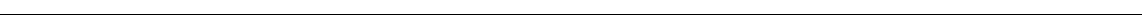
Fig. 1 Structure of the SepCysE-SepCysS-tRNA Cys ternary complex. a Orthogonal views of the ternary complex drawn in ribbon model. A dimer of the SepCysE N-terminal domain (SepCysE(NTD), yellow orange) is tightly bound to a dimer of SepCysS (blue) with their two-fold axes aligned. From one of the NTDs of the SepCysE dimer, a linker chain extends to the C-terminal domain of SepCysE (SepCysE(CTD), red), which in turn binds to the elbow region of tRNA Cys (orange). The CCA terminus of tRNA Cys is in contact with the active site of SepCysS. A stick representation of PLP is also drawn at the active site. Black and red dashed lines represent fl exible loops connected to the disordered N-helix and CTD of SepCysE, respectively. A schematic representation of SepCysE with domain boundaries is given at the bottom. b Close-up views of interactions between SepCysE(CTD) and tRNA Cys . Interactions are mainly nonspeci fi c between main-chain phosphates of tRNA Cys and lysyl side-chains at α 4 and α 6 of SepCysE(CTD). Hydrogen bonds are indicated by dashed lines. c A detailed view of the recognition of tRNA Cys by SepCysS. The tRNA Cys is bound to SepCysS at two regions marked by yellow/green circles in a . Left panel shows the interactions at the helix-loop-helix-loop region (green circle in a ). Middle panel shows a close-up of the U73 recognition site. Right panel shows the interactions at the N-terminal chain (yellow circle in a ). d Binding assays of the SepCysE-SepCysS complex to tRNA variants by gel fi ltration. The result shows the importance of the discriminator base U73. Blue and red lines represent the absorption at a wavelength of 280 nm and of 260 nm,